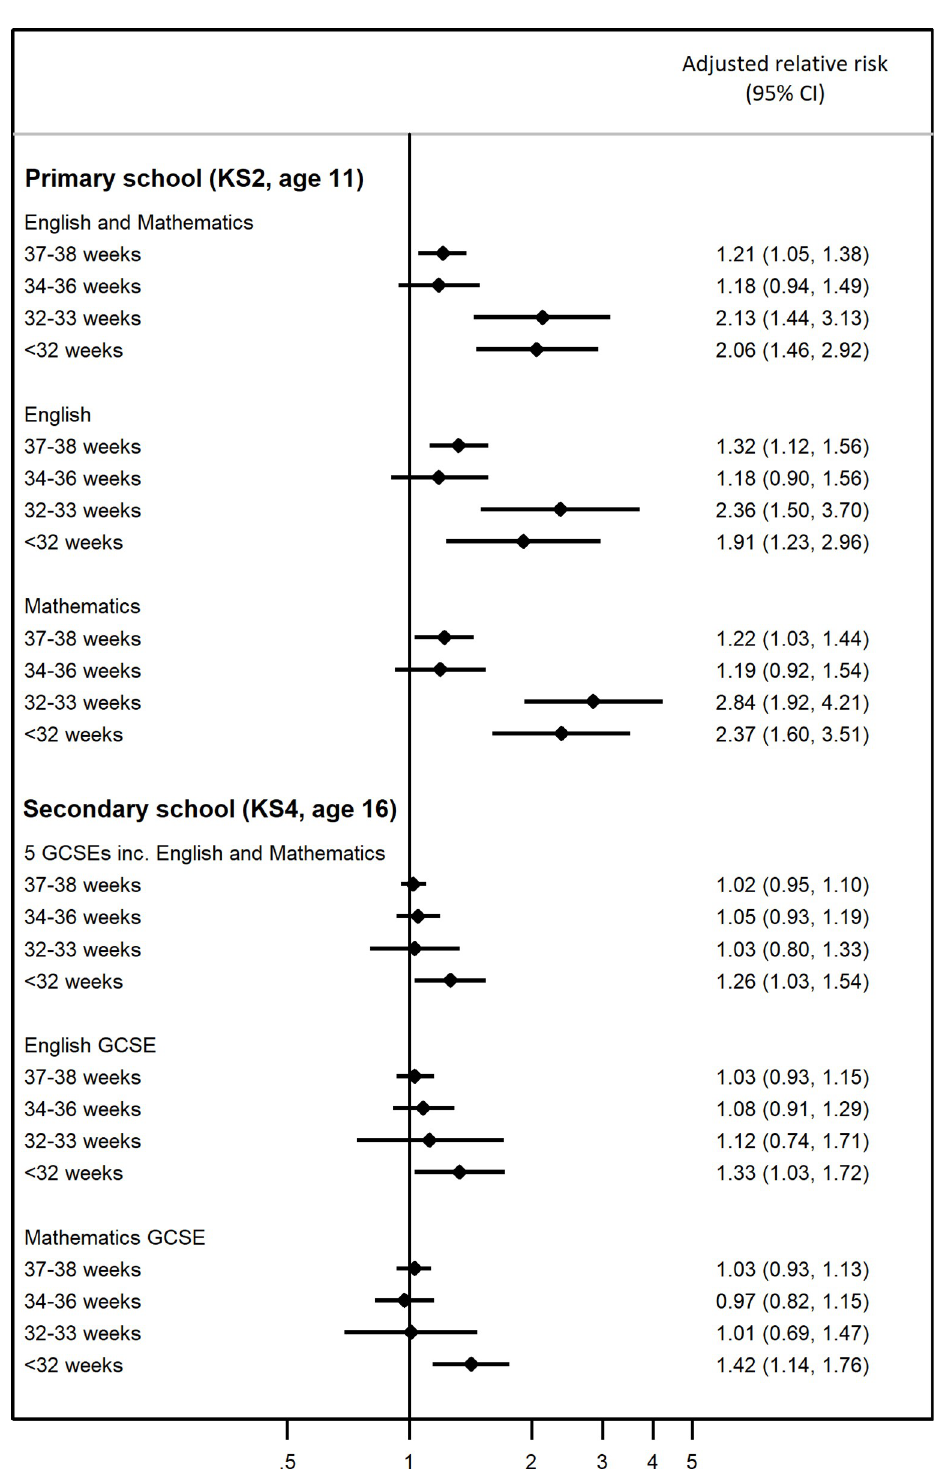
Fig 2. Adjusted relative risks for the association between gestational age at birth and attainment at Key Stage 2 (KS2; end of primary school, age 11) and at Key Stage 4 (KS4; end of secondary school, age 16) in the Millennium Cohort Study children born 2000–2001 in England. (GCSE: General Certificate of Secondary Education).